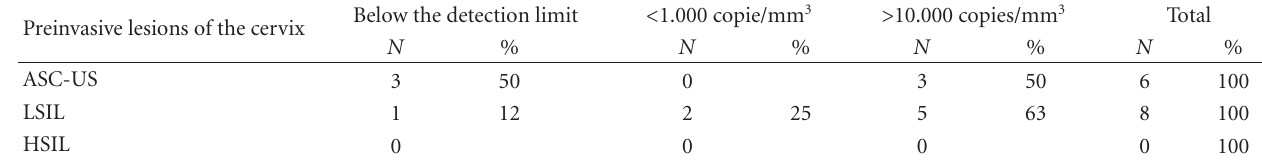
Table 3: Frequency of abnormal cytology correlated with viral load in HIV-positive women. Preinvasive lesions of the cervix